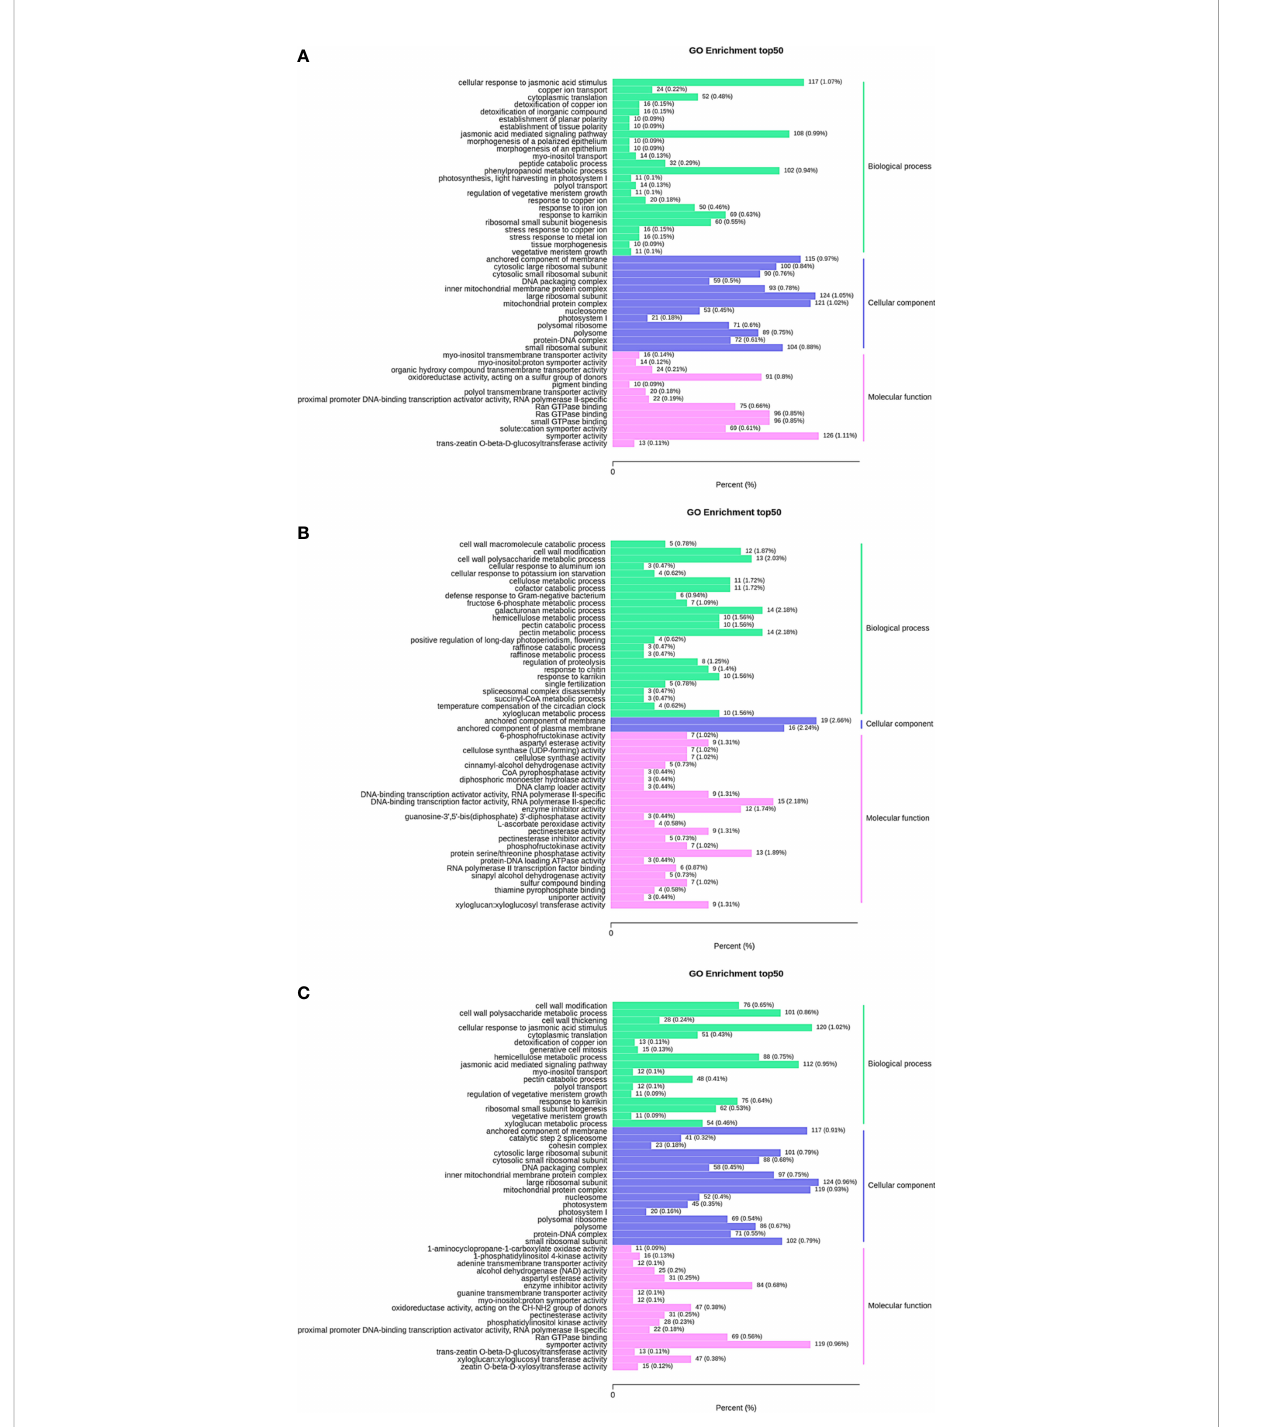
FIGURE 4 GO enrichment column plot. Differentially expressed genes generated by a comparison of (A) 35 d vs. 63 d, (B) 63 d vs. 69 d, (C) 35 d vs. 69 d are grouped into different GO terms of three ontologies: biological process, cellular component and molecular